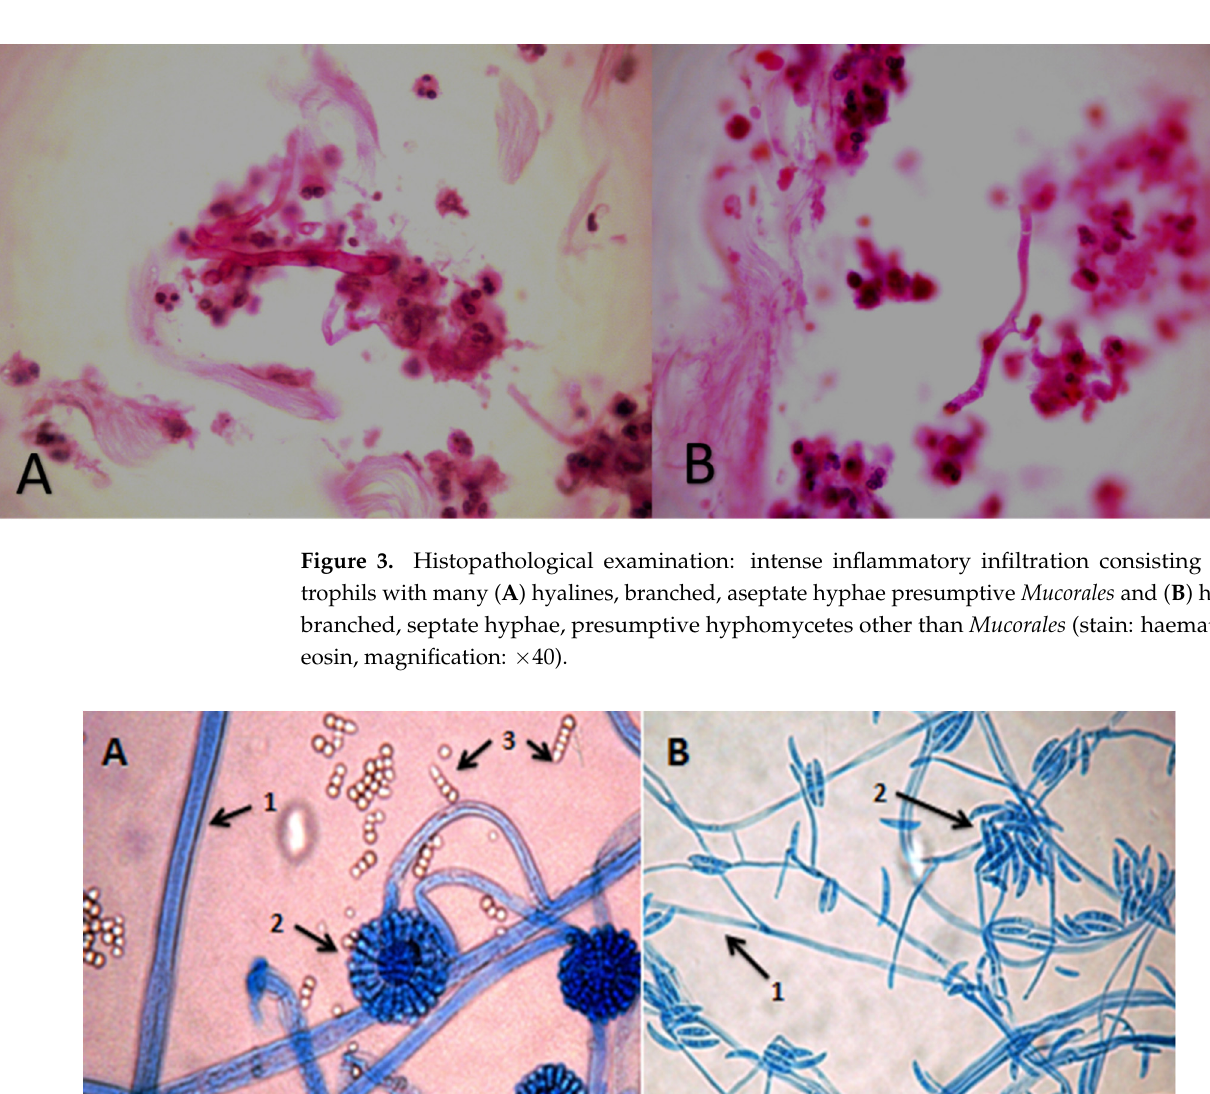
Figure 2. Direct microscopy: wet tissue mount examined with KOH and ( A ) Blankophor-P ( B ) broad, non- septate, ribbon- like hyphae with right-angle branching, characteristic of Mucorales.